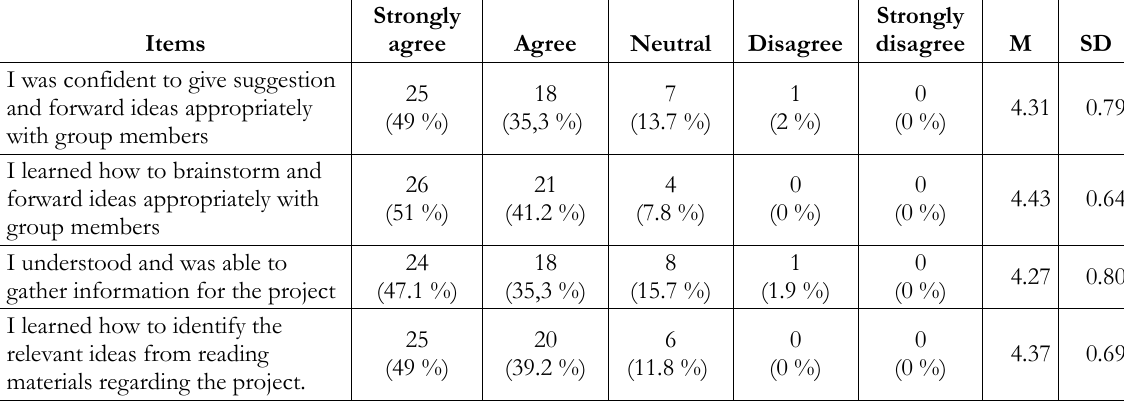
Table 5. The data analysis of students’ perceptions of project management